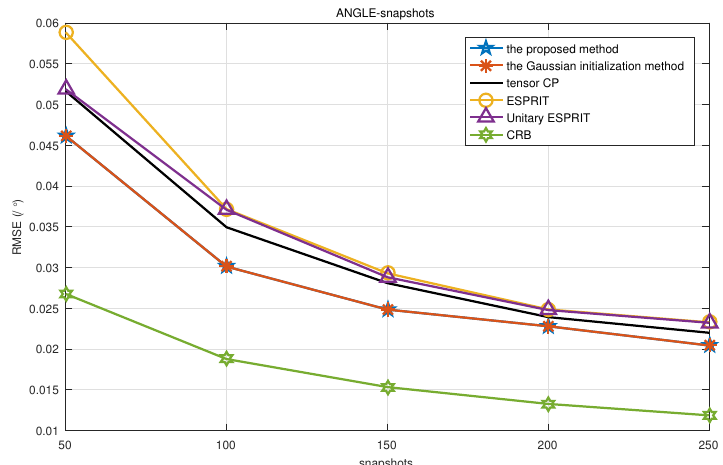
Figure 5. RMSE of angle estimation versus snapshots.